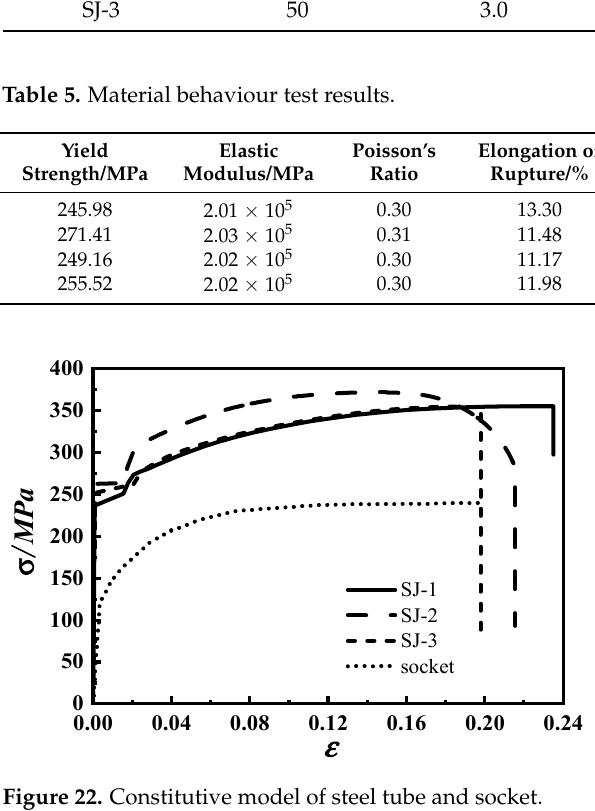
Table 5. Material behaviour test results.